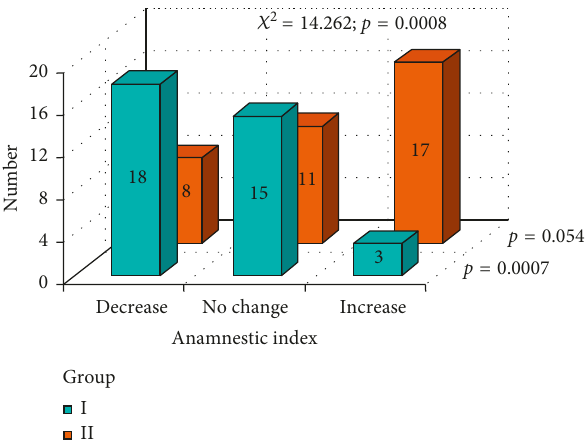
Figure 7: Changes in AI index after the prosthodontic therapy in both groups.